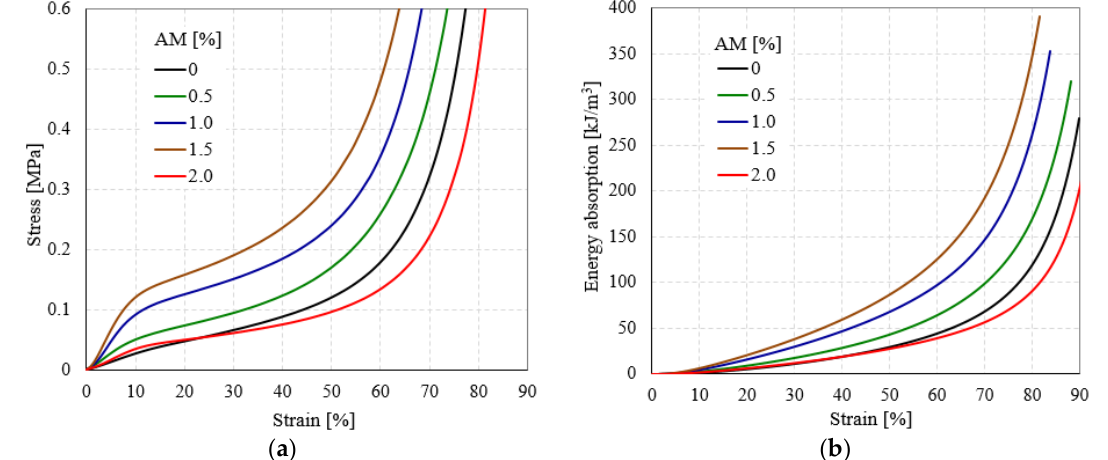
Figure 4. Compressive engineering stress-engineering strain ( a ) and energy absorption-engineering strain ( b ) curves of semi-rigid PU foams.